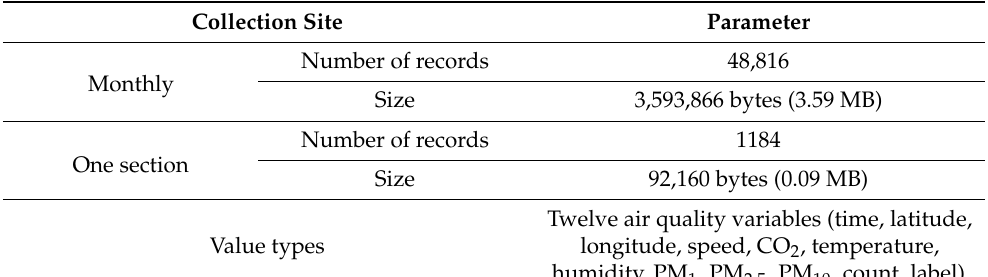
Figure 5. Daily Traveling Distance for Data Collection. Table 4. Description of data features and sample sizes for data collection process.